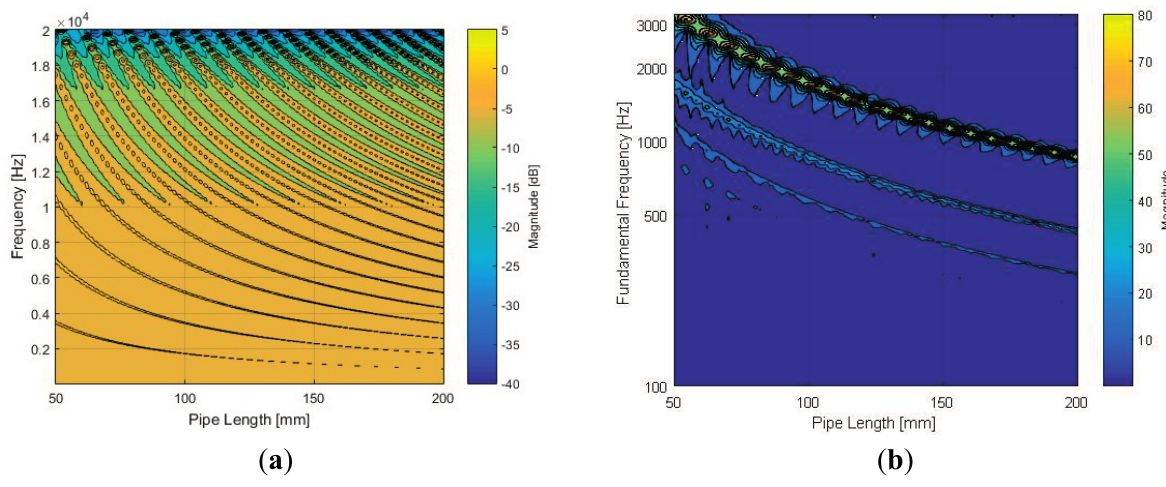
Figure 8. Simulated results for cylindrical pipe ( d = 10 mm, h = 3 mm, and w = 8 mm) with various lengths: ( a ) frequency response in decibel scale and ( b ) fundamental frequency distribution in absolute scale.